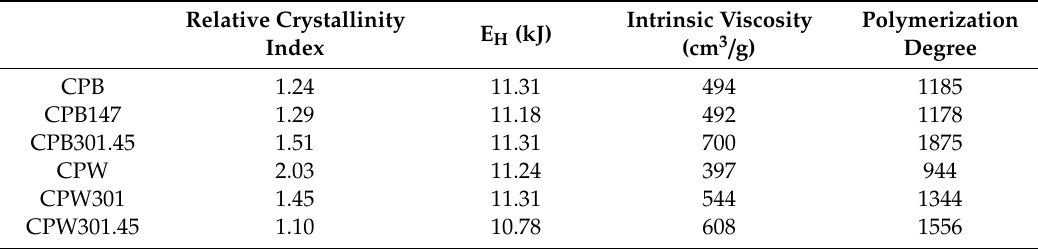
Table 3. Relative crystallinity index, energy related to hydrogen bonds (E H ), and polymerization degree of the cellulose pulps